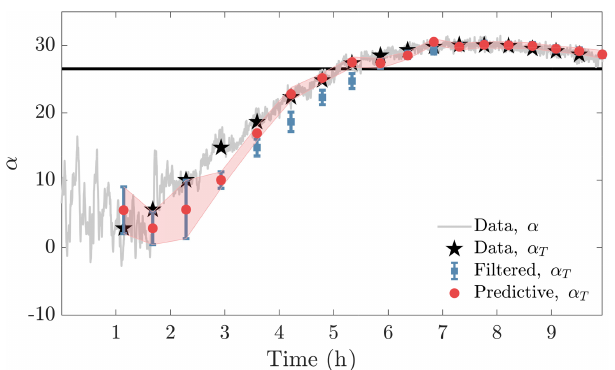
Figure 6. Comparison of the mean wind direction estimation meth- ods to the measured instantaneous ( α ) and mean ( α T ) wind direc- tion data. A standard approach is shown where the low-pass-filtered wind direction α T is estimated through a moving average. The pre- dictive method is shown in which α T is estimated using the pro- posed DirectionEstimation algorithm, described in Fig. A1 and Al- gorithm 1. The horizontal black line corresponds to the wind direc- tion of alignment between turbines 1 and